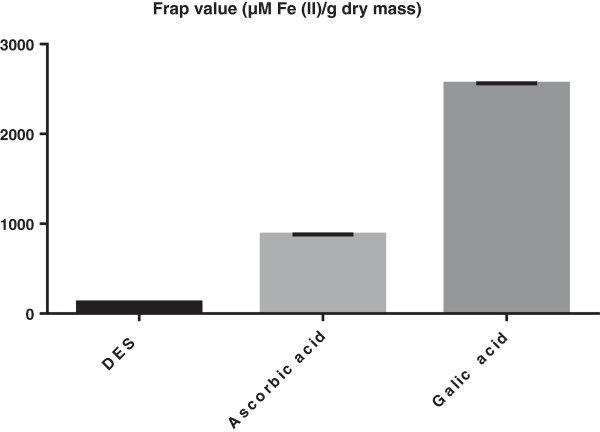
Ferric reducing/antioxidant power assay. The FRAP value (μM Fe (II)/g dry mass) of DES in compare with that of ascorbic acid and gallic acid.